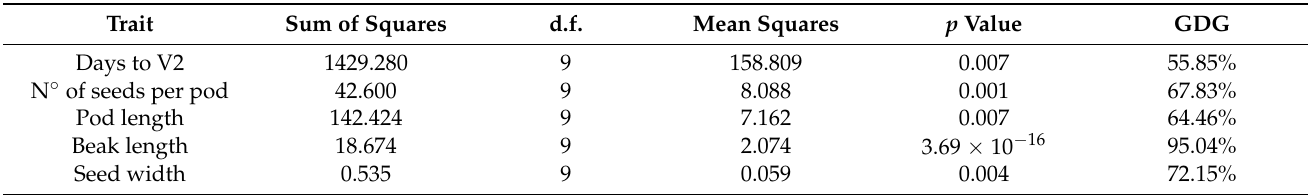
Table 3. Values obtained from the ANOVA analysis performed in Past3 for each of the variables that had r 2 values greater than 0.95.